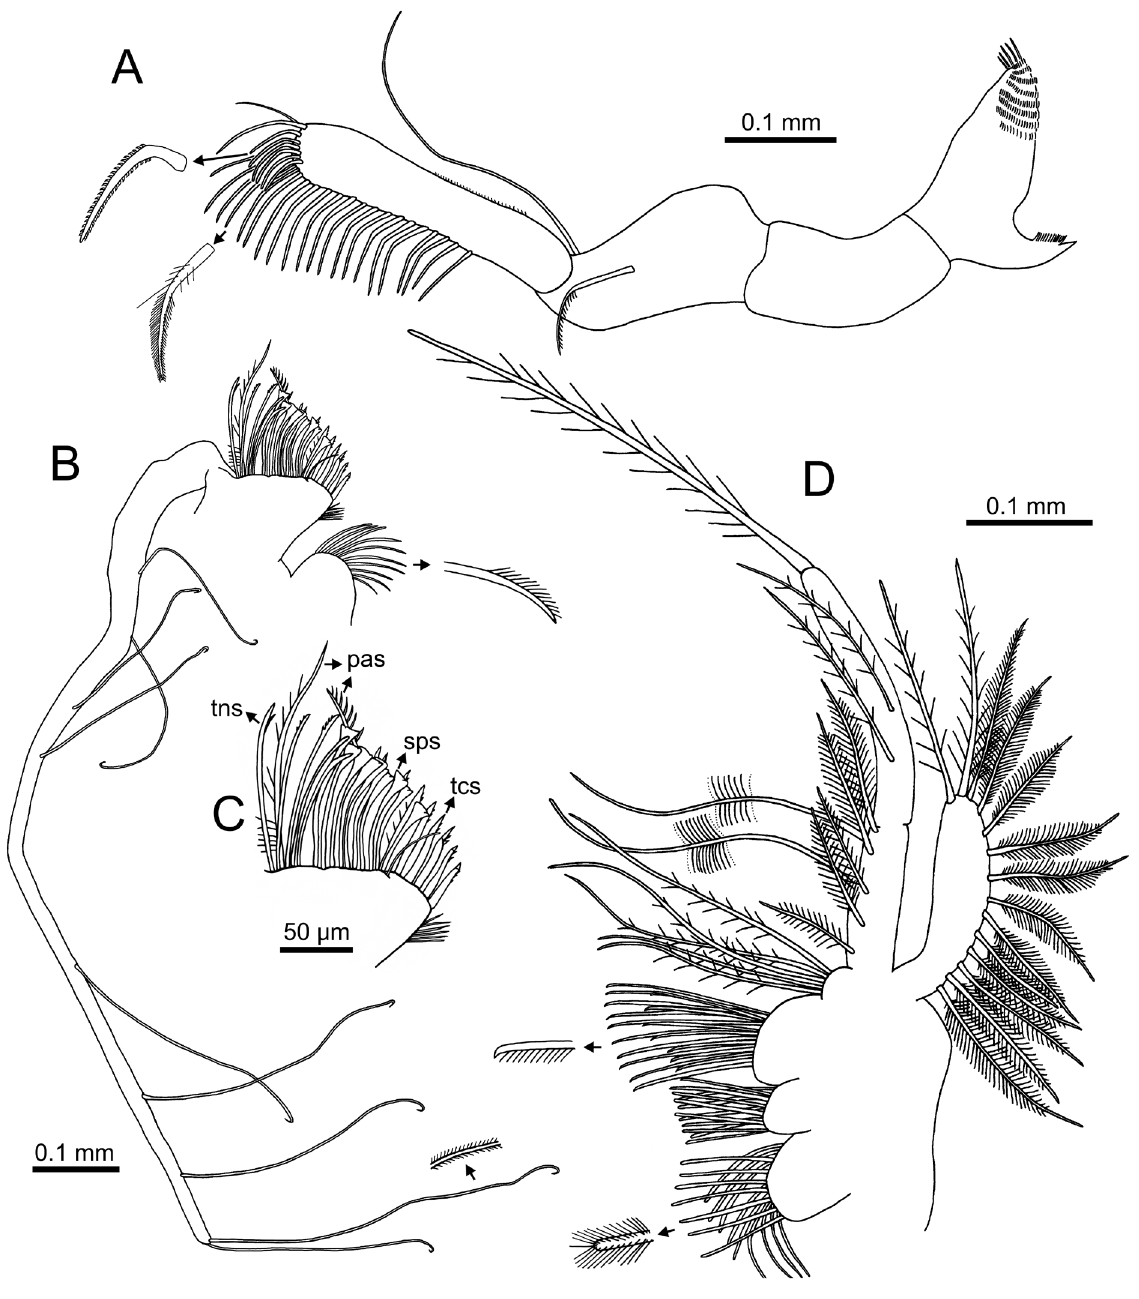
Fig. 12. Sarsinebalia ledoyeri sp. nov. Postovigerous female, paratype (MNCN 20.04/13708). A . Mandible. B . Maxilla I. C . Maxilla I, endites, detail. D . Maxilla